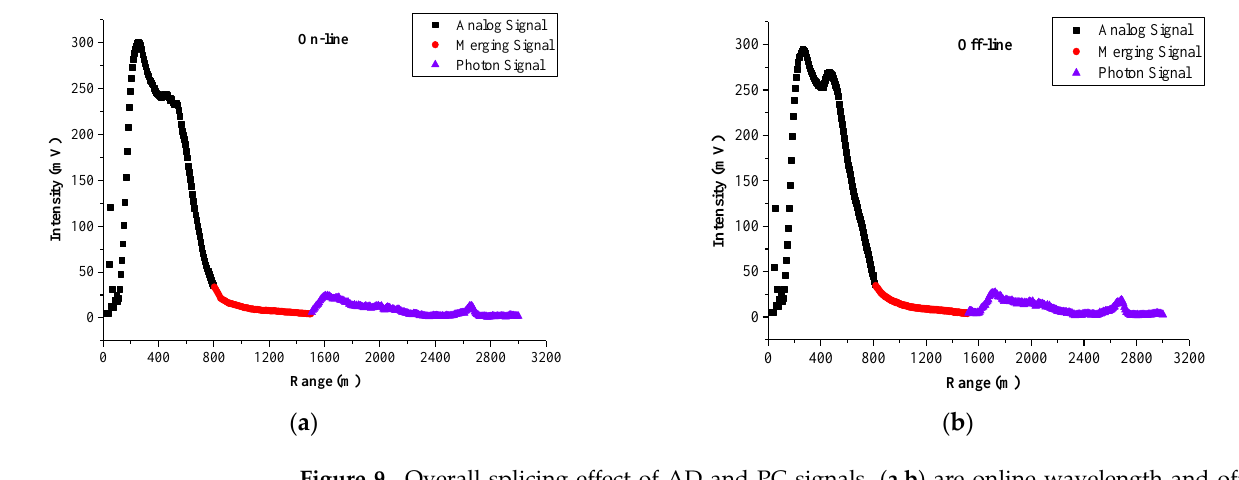
Figure 9. Overall splicing effect of AD and PC signals, ( a , b ) are online wavelength and offline wavelength, respectively.